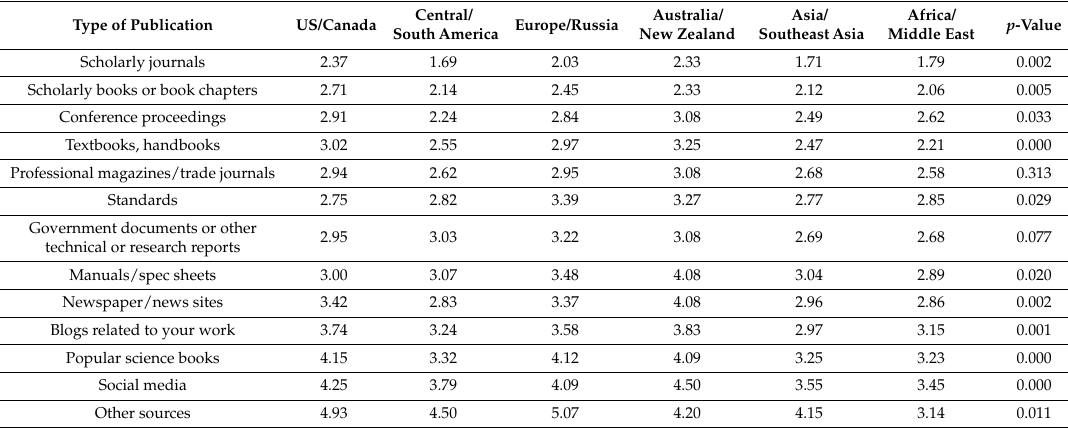
Table 6. Importance of types of publications to respondents’ work (1 = absolutely essential; 2 = very important; 3 = important; 4 = somewhat important; 5 = not at all important.